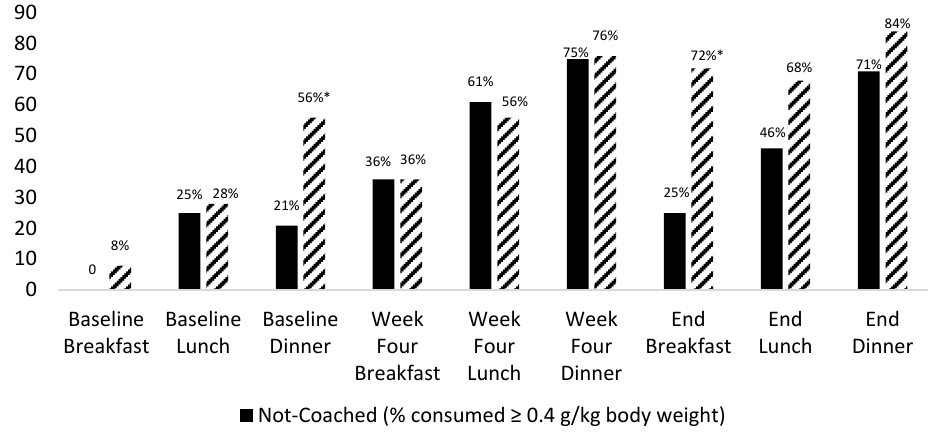
Figure 1. Percentage of participants meeting protein prescription at meals by group at baseline, 4 and 12 weeks (end). * Significant difference coached versus not-coached group participants.